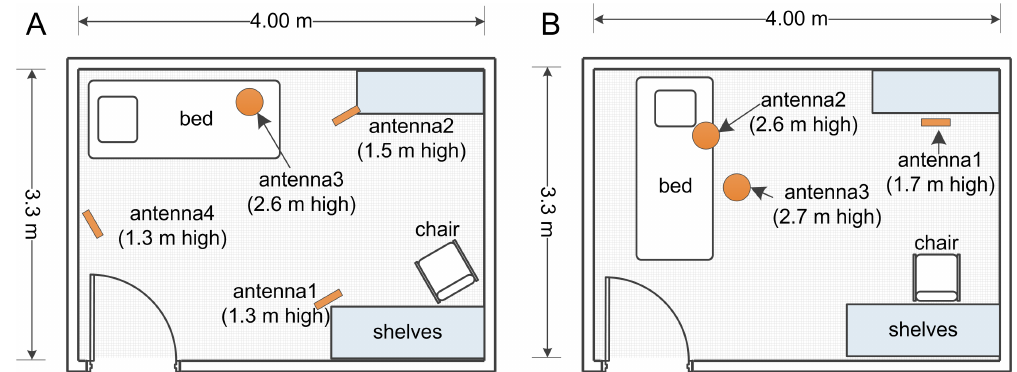
Figure 4. The two room configurations used in the study. Configuration of equipment with antennas on ceiling level shown as circles and vertical antennas shown as rectangles facing either the bed or chair. ( A ) Room 1, antenna3 is at ceiling level on top of the bed and the rest of the antennas are on a vertical stand. Antenna2 is inclined towards the chair and antenna1 and antenna4 face front (chest level) towards the bed area; and ( B ) Room 2, antenna2 and antenna3 are at ceiling level tilted towards the bed and antenna1 is on a vertical stand inclined towards the